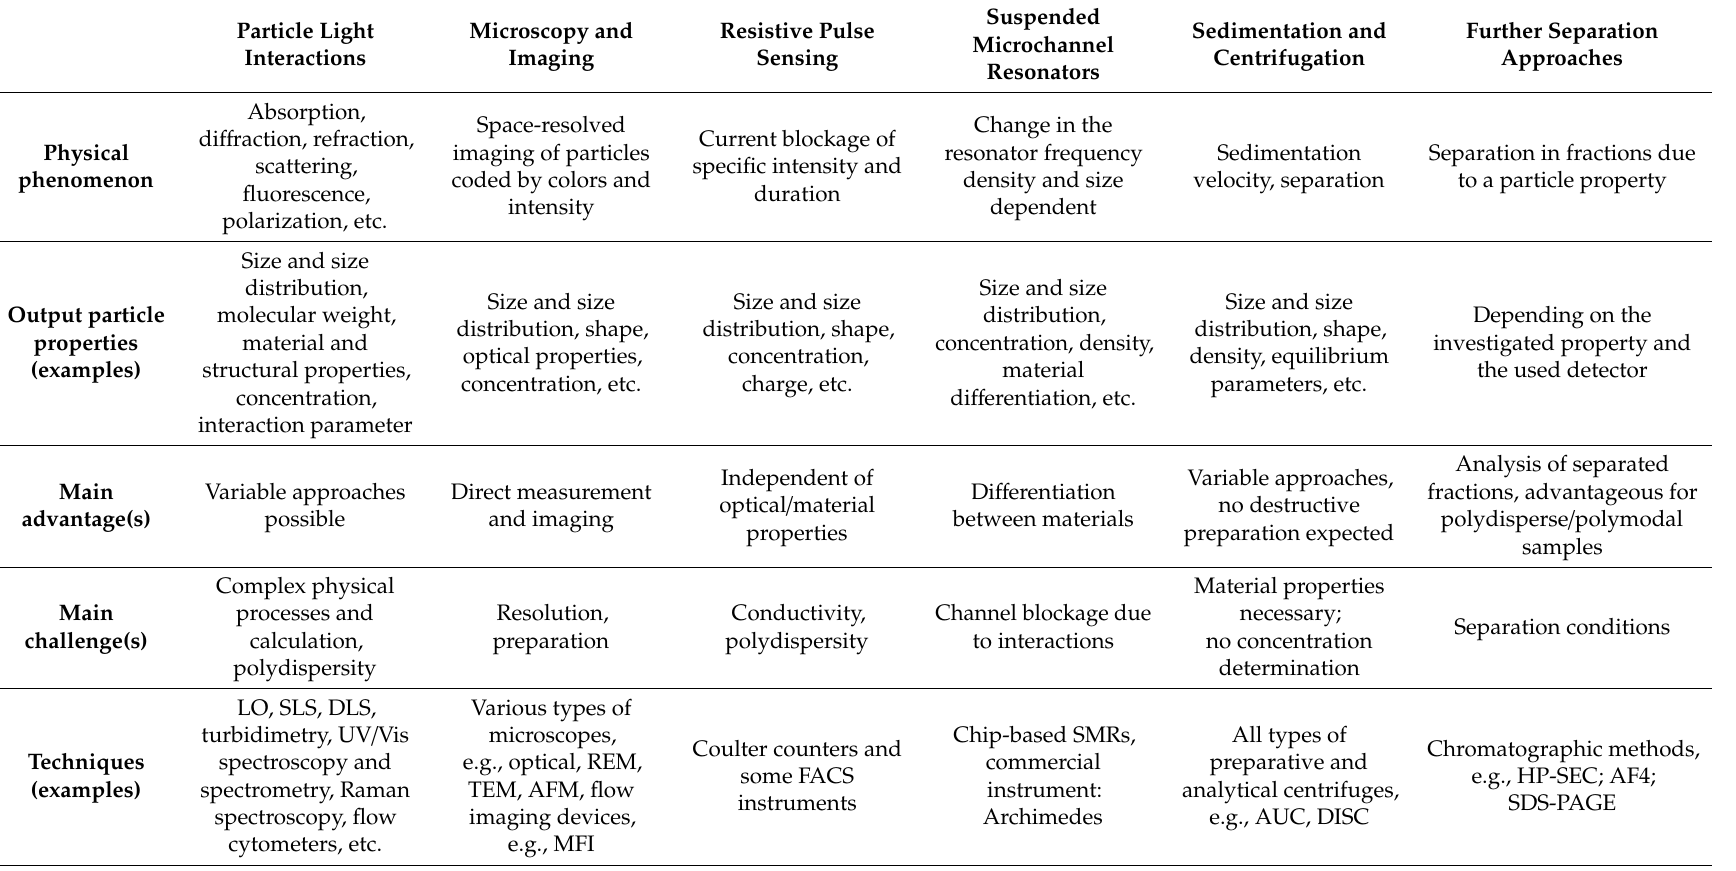
Table 1. Particle detection and characterization